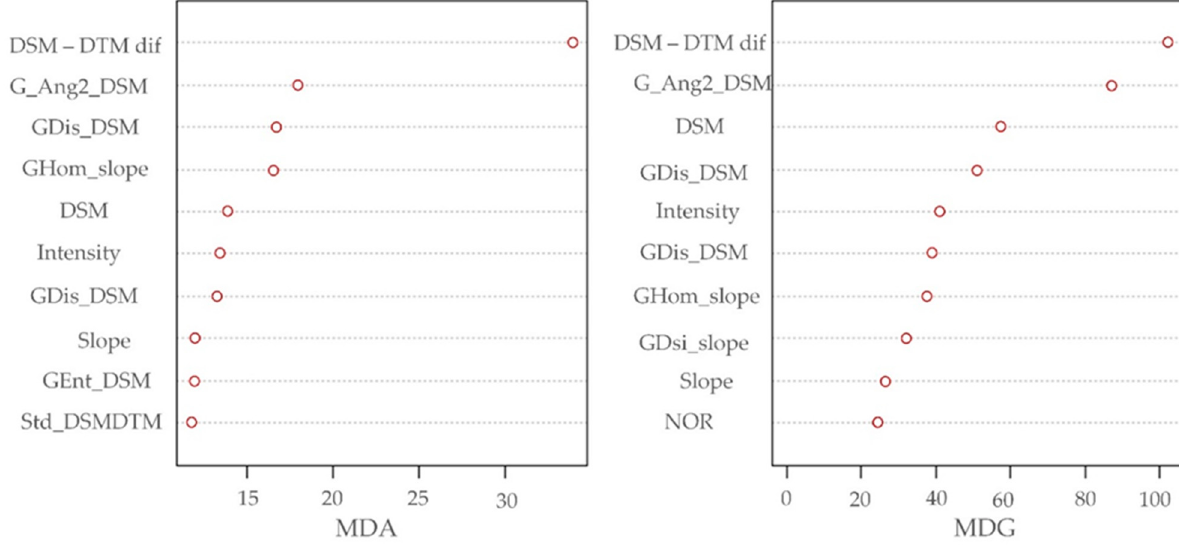
Figure 8. Top 10 variable selection with 30%–70% training–testing data split.